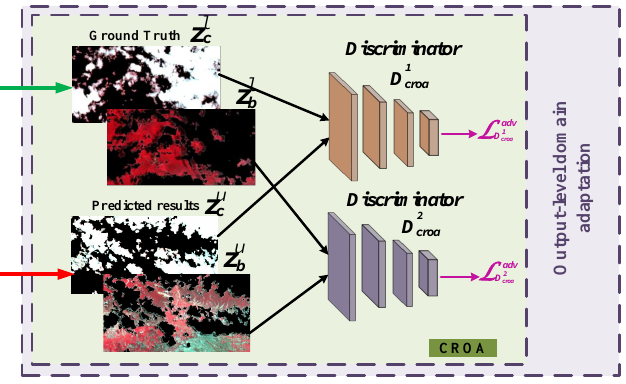
Figure 5. Structure of the proposed